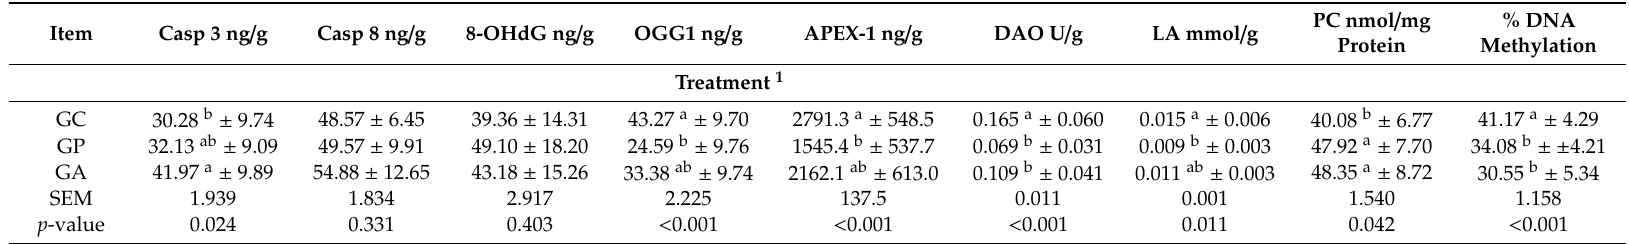
Table 3. Oxidative and epigenetic DNA damage and activity of repair enzymes in intestinal wall of chickens (6 day of